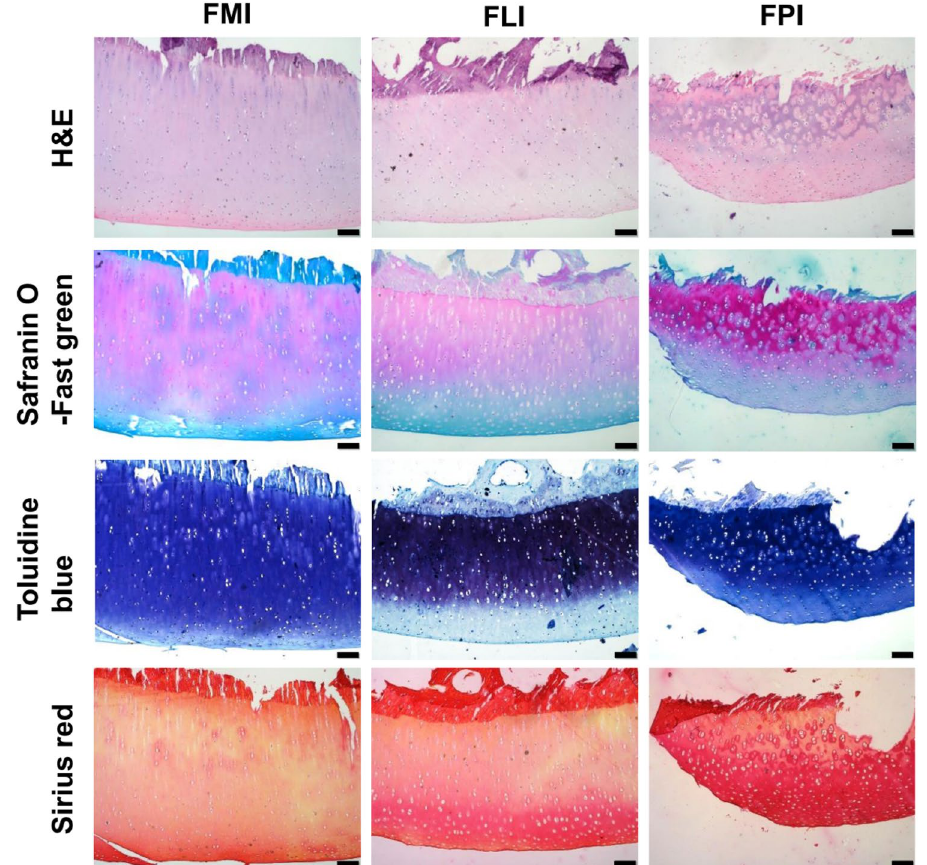
Figure 5. Histological analysis of specific regions in femoral cartilage using H&E, Safranin O-fast green, Toluidine blue and Sirius red staining. Scale bar: 100